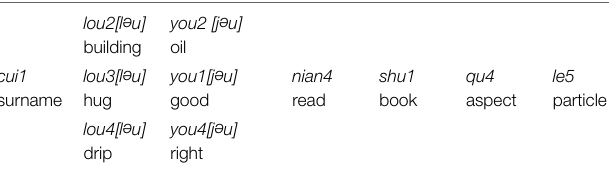
TABLE 5 | The second set of the stimuli in which the numbers of the syllables represent the five lexical tones in Mandarin: 1 for H (High tone), 2 for R (Rising tone), 3 for L (Low tone), 4 for F (Falling tone), and 5 for N (Neutral